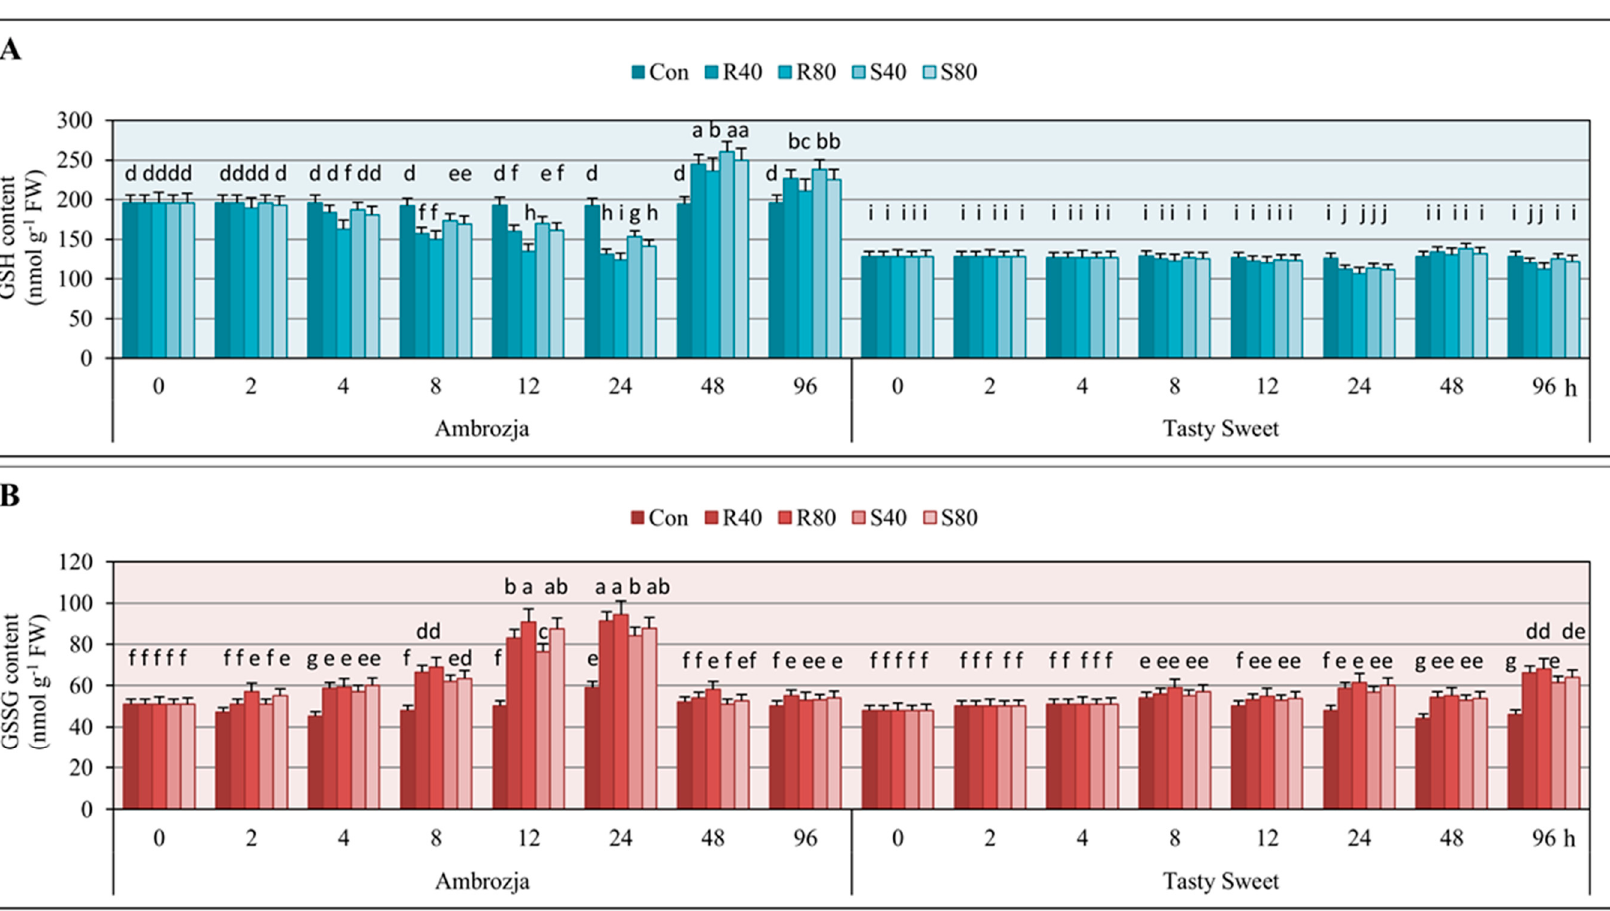
Figure 1. Effect of the cereal aphids’ infestation on the content of reduced glutathione (GSH) ( A ); and oxidized glutathione (GSSG) ( B ) in the seedlings of Ambrozja and Tasty Sweet maize cultivars. R40, R80—maize plants of a certain genotype infested with 40 or 80 R. padi females per seedling, accordingly; S40, S80—maize plants of a certain genotype infested with 40 or 80 S. avenae females per seedling, respectively. All data are presented as the mean (±SD) of three independent biotests, and significant differences between tested groups of the maize plants are denoted by different letters ( p < 0.05; post-hoc Tukey’s test).